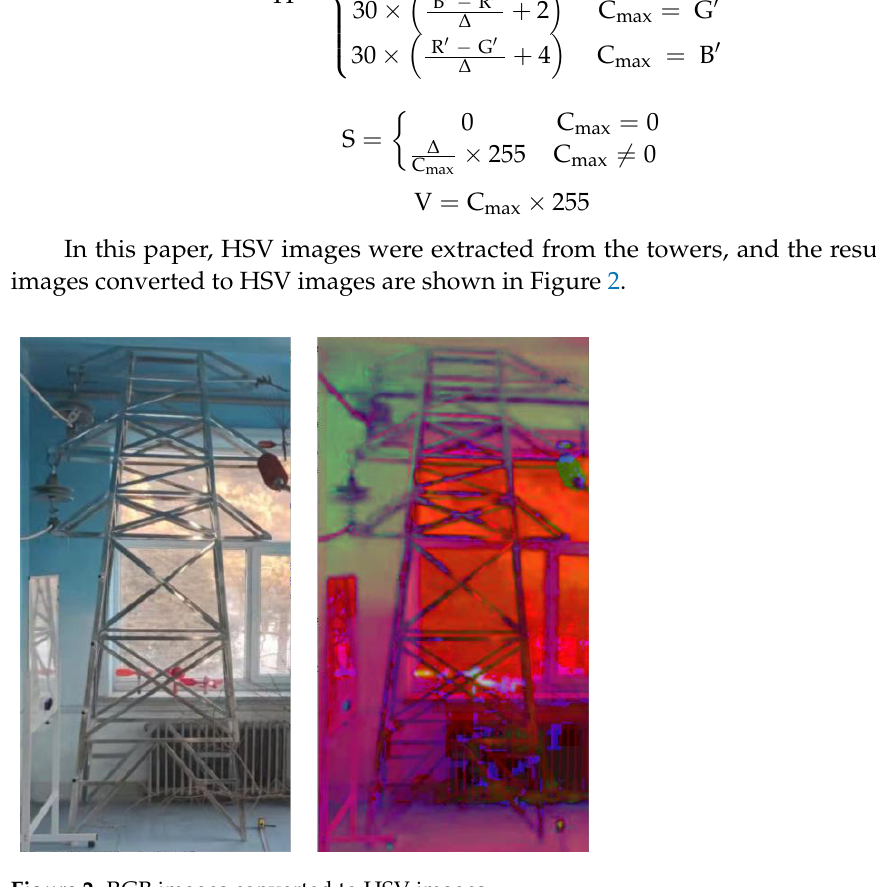
Figure 3. HSV image enhancement results. 2.3. Tower Contour Extraction In this paper, the value range of this top red is determined by taking the histogram of the components as the boundary standard for our segmentation. The histogram of HSV images is shown in Figure 4.